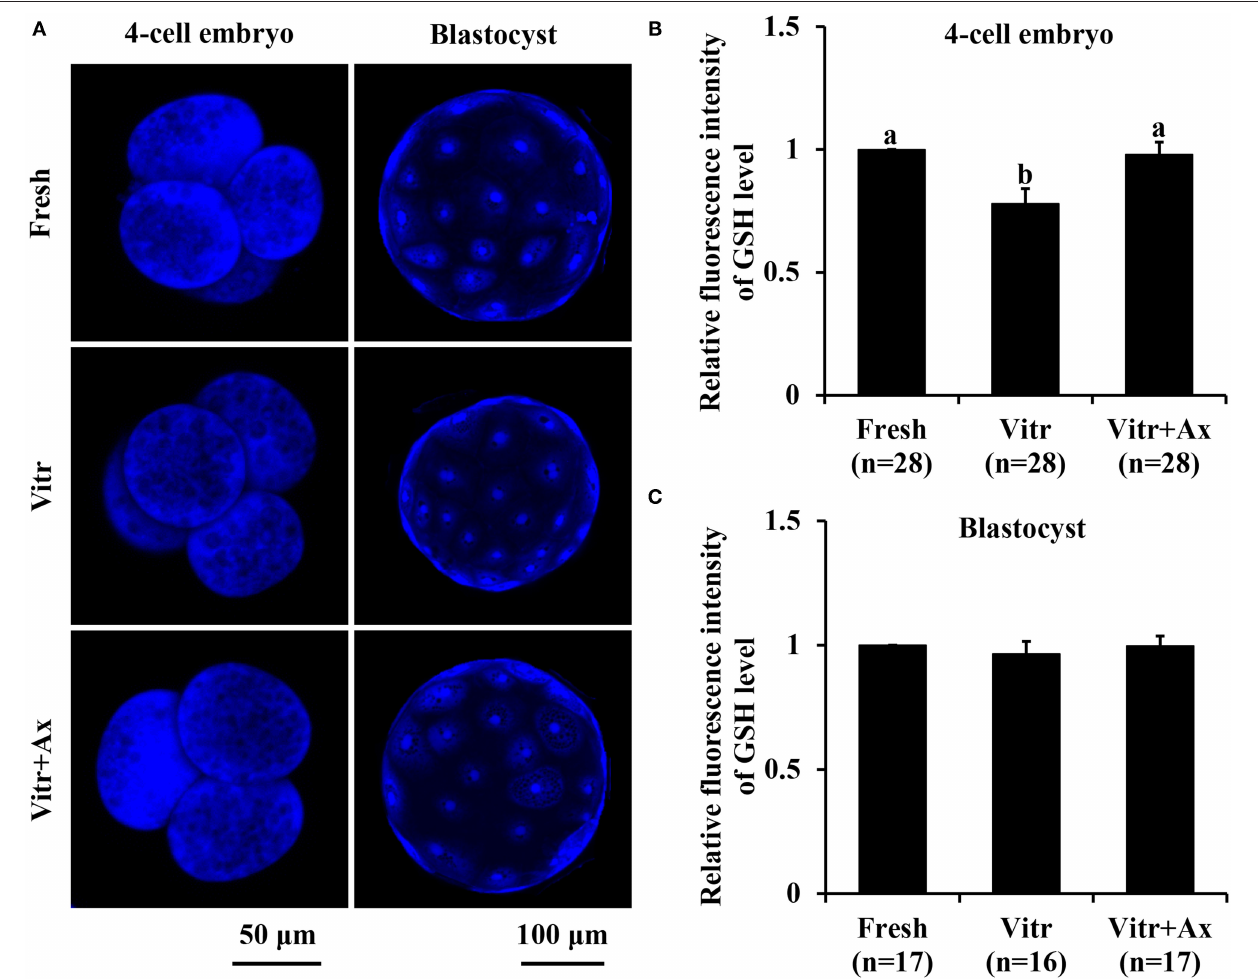
FIGURE 3 | Effects of astaxanthin (Ax) supplementation on intracellular glutathione (GSH) level in resultant 4-cell embryos and blastocysts. (A) Representative images of GSH signals stained with ThiolTracker TM Violet. (B,C) Graphical representation of GSH level by quantifying the relative fluorescence intensity. Four replications were performed. Data are the mean ± SEM values. Different superscripts above columns indicate significant differences ( P < 0.05). The three experimental groups: fresh zygotes (Fresh group), vitrified zygotes (Vitr group), and vitrified zygotes cultured with Ax (Vitr + Ax group).